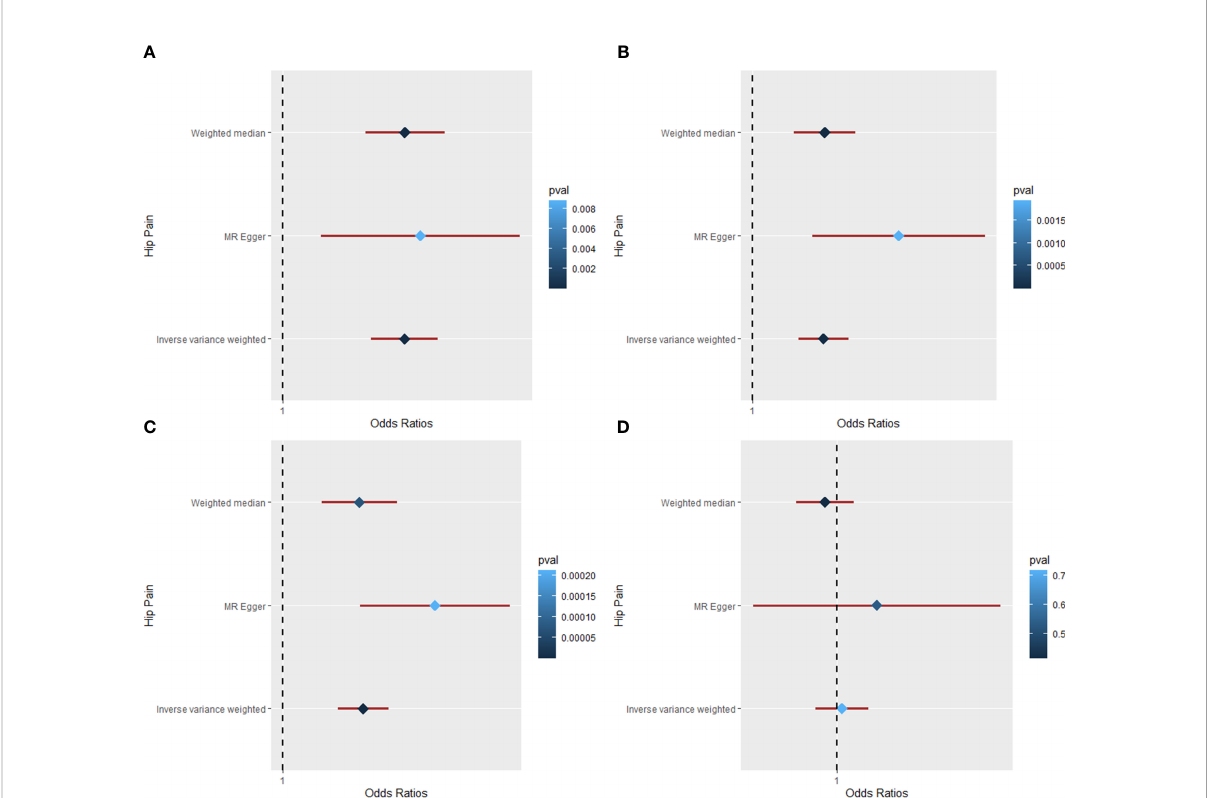
FIGURE 3 The Mendelian randomization analysis for causal effects of obesity on hip pain. (A) Forest plot about the causal effect of body mass index on hip pain. (B) Forest plot about the causal effect of waist circumference on hip pain. (C) Forest plot about the causal effect of hip circumference on hip pain. (D) Forest plot about the causal effect of waist-to-hip ratio on hip